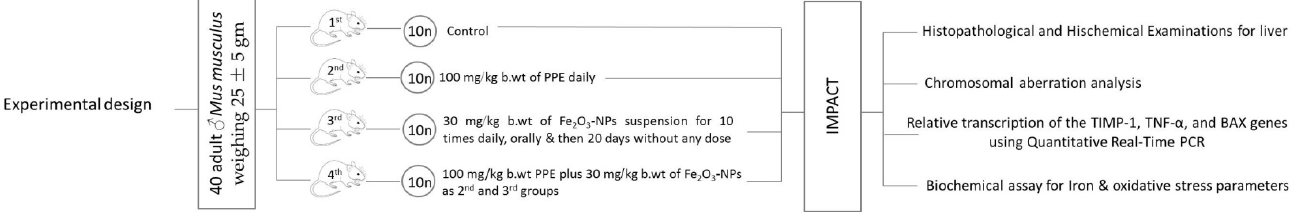
Figure 1. Schematic figure for explaining the experimental